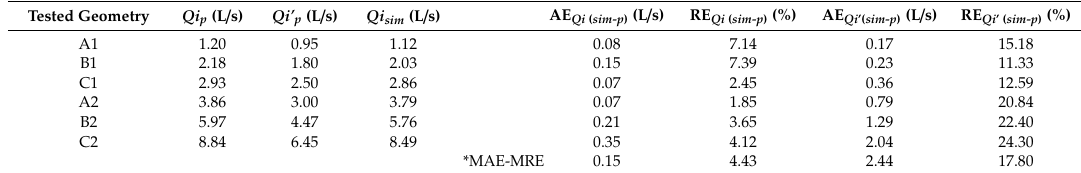
*MAE: Mean Absolute Error and MRE: Mean Relative Error between the flow rate for the initiation of the jet flow, for the di ff erent physical models, obtained by the proposed formulation Qi p and Qi’ p , respectively, considering or not the term that depends on the radius, and the flow rate for the initiation of the jet flow obtained by numerical simulation Qi sim .